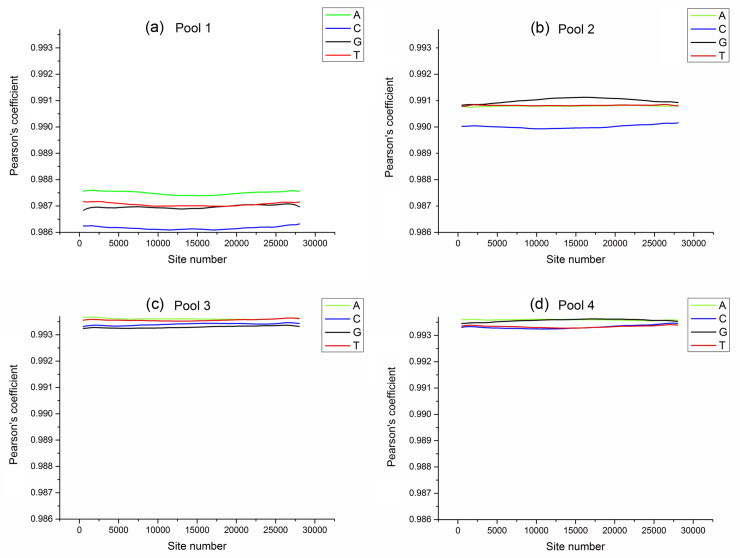
Correlation between site number and Pearson’s coefficients of allele frequencies between pool- and individual- sequencing.(a) Pool 1 that contains three families (F1-F3), each with five individuals. (b) Pool 2 that contains the same three families with pool 1, each with 10 individuals including those used in Pool 1. (c) Pool 3 that contains six families (F1-F6), each with five individuals, and eight of the fifteen individuals from F1-F3 were the same as those in Pool 1. (d) Pool 4 that contained ten families, including all 53 individuals used in Pool 1, Pool 2 and Pool 3. The x-axis and y-axis categorizations correspond to site number and Pearson’s coefficient of allele frequencies between pool- and individual- sequence, respectively.